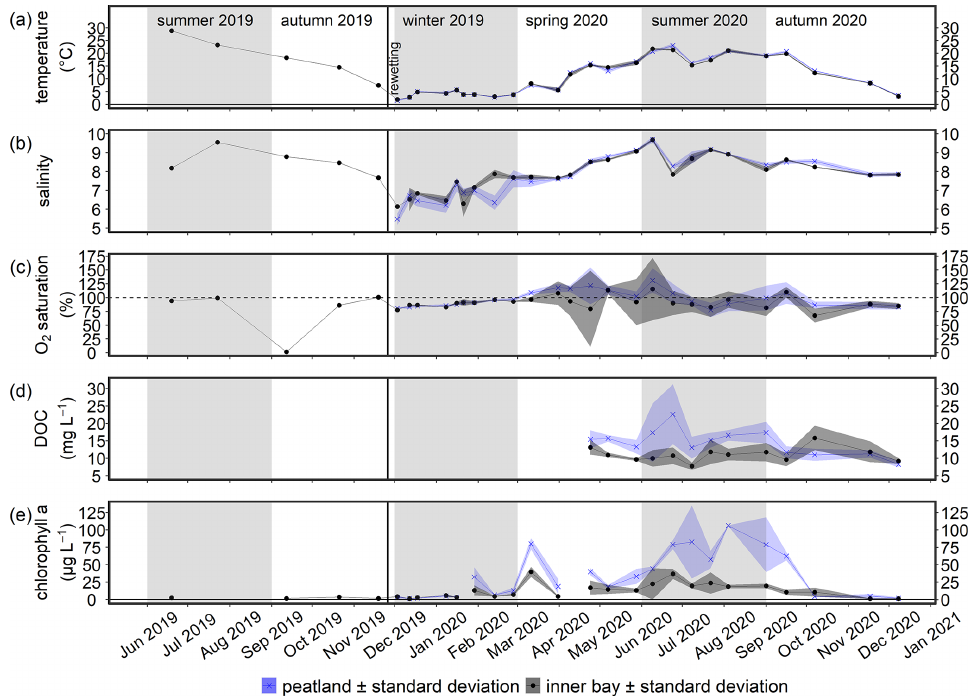
Figure 3. Time series of the mean (a) temperature, (b) salinity, (c) O 2 saturation, (d) DOC concentration, and (e) chlorophyll a concentration ( ± standard deviation) in the surface water from June 2019 to December 2020. Data from the flooded peatland ( n = 6) are shown in blue and data from the inner bay ( n = 2 or 3, as explained in Sect. 2.3) in black. The vertical black line indicates the rewetting event.